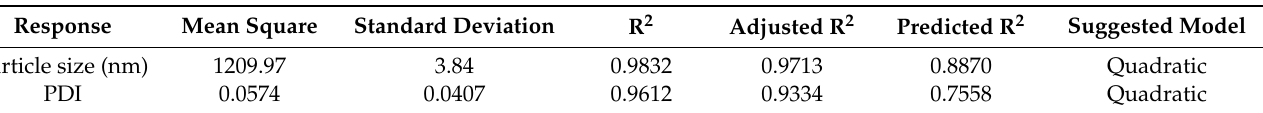
Table 3. Summary of regression study for responses, such as particle size, PDI and transmittance for